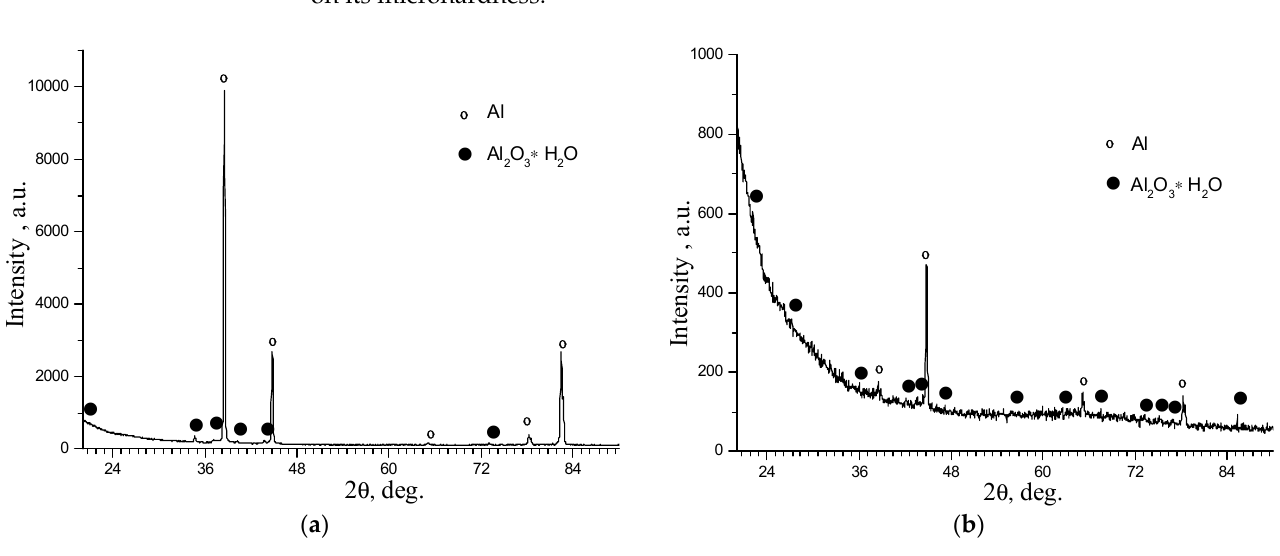
Figure 9. Typical phase compositions of hard anodized layers synthesized: ( a ) for 2 h and ( b ) 3 h at an electrolyte temperature of − 4–0 °C.